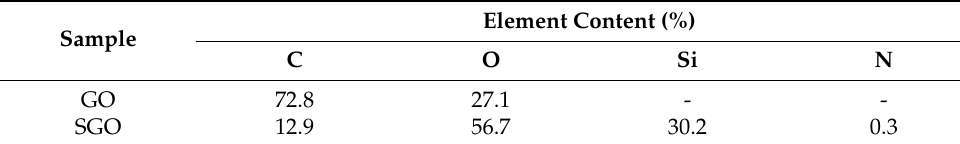
Table 2. Elemental content of GO and SGO measured by XPS.